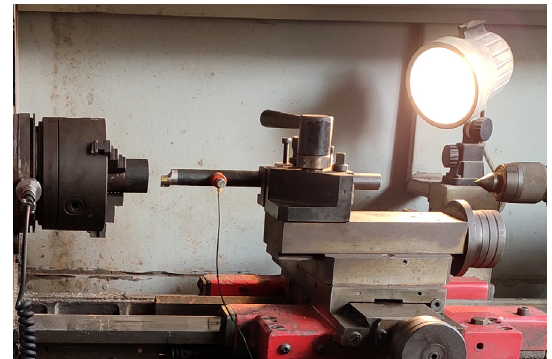
Figure 6. Experimental setup